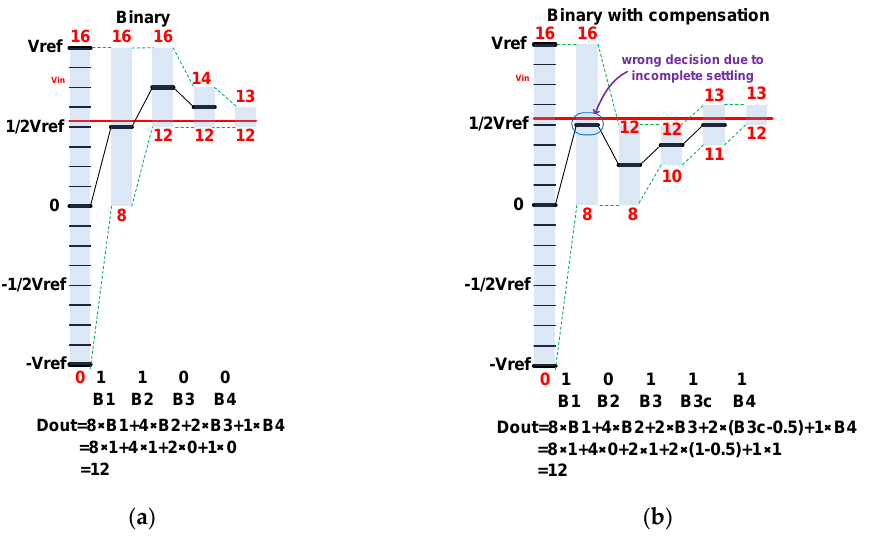
Figure 6. The calibration circuit of the non-linearity.